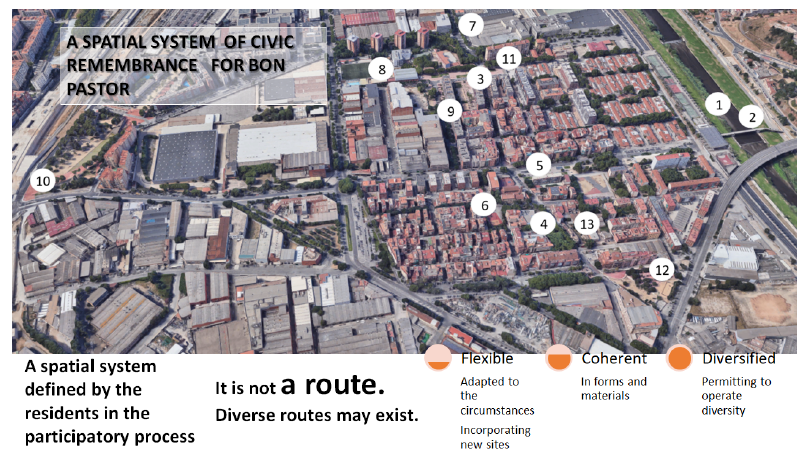
FIG. 7 Plant of the neighbourhood that summarizes the participatory process, with the 13 points of interest for the civic remembrance project. Based on Google